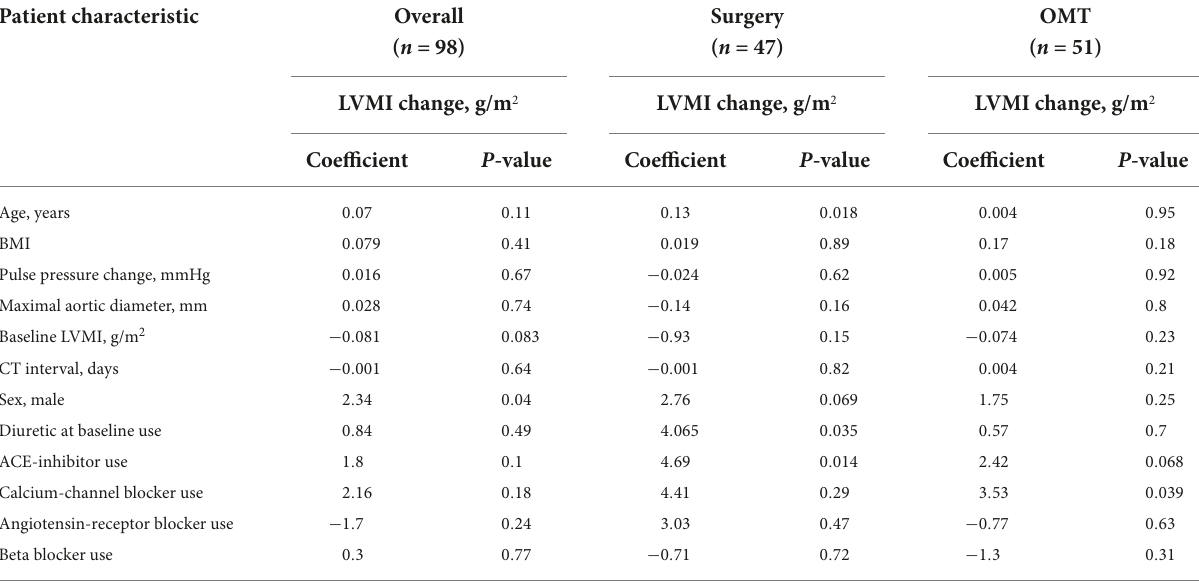
TABLE 3 Univariate regression analysis of left ventricular mass index (LVMI) change with baseline clinical parameters among treatment groups. Patient characteristic Overall Surgery OMT ( n = 98)